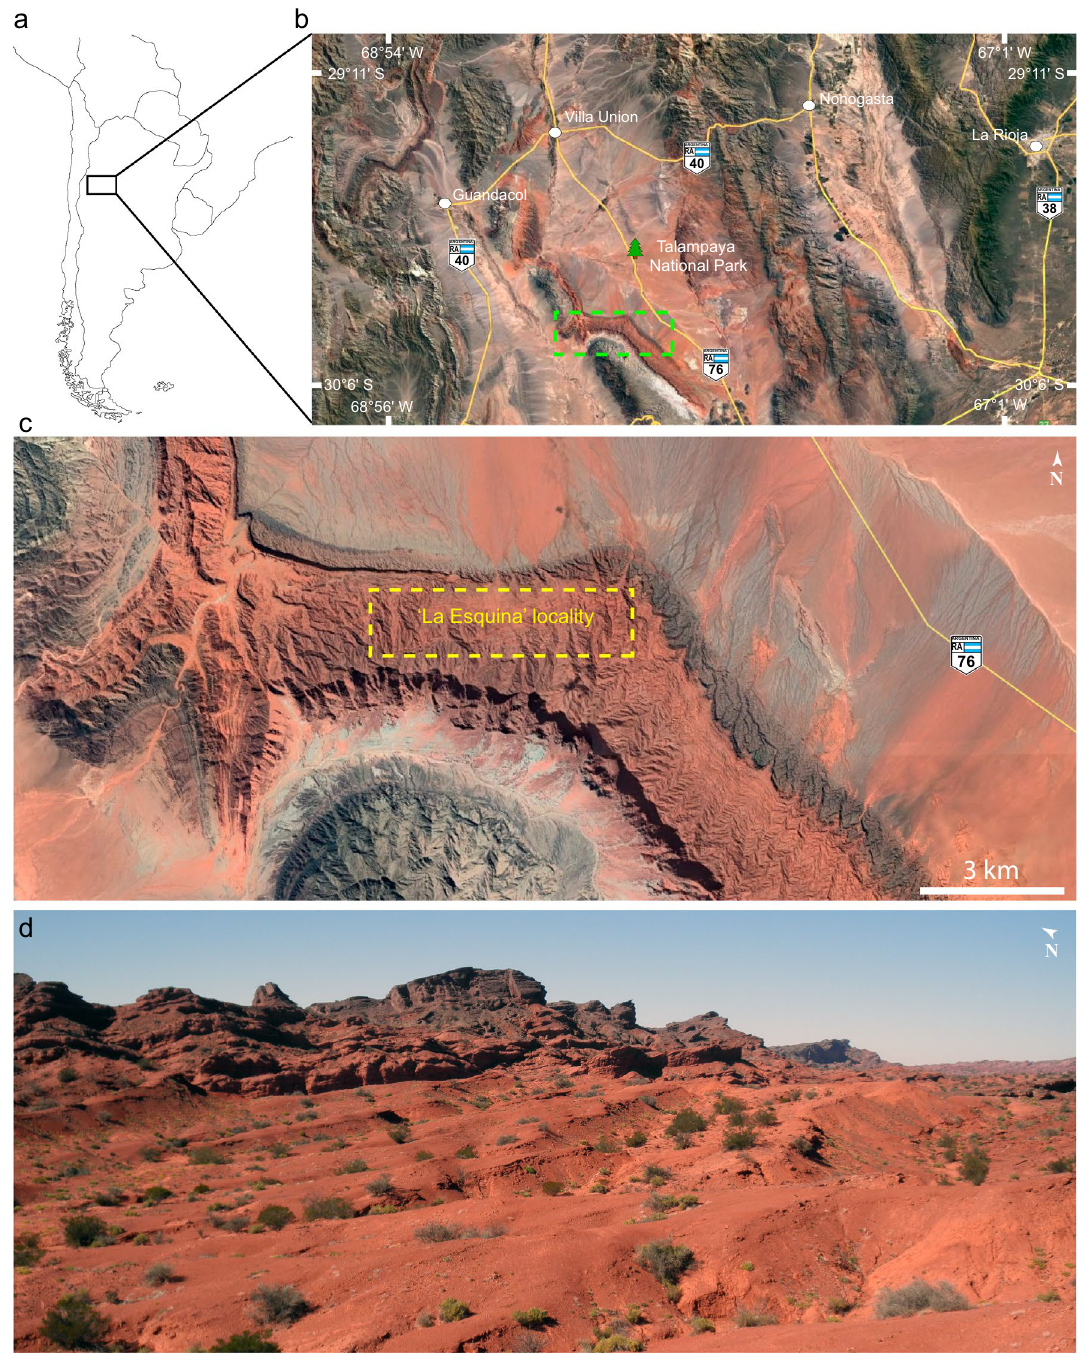
Figure 1. Geographic location of the ‘La Esquina’ locality where Tessellatia bonapartei holotype (PULR-V121) was found. ( a ) Southern South America; ( b ) satellite image of north-western Argentina depicting the study area (green, dotted-line rectangle) within the Talampaya National Park, La Rioja Province; ( c ) satellite image showing the main outcrops of the Los Colorados Formation where the rich faunal assemblage of the ‘La Esquina’ locality was found (yellow, dotted-line rectangle); ( d ) photograph of the outcrops at the ‘La Esquina’ locality portraying the levels from where Tessellatia bonapartei holotype (PULR-V121) was recovered. Map drawn with Adobe Illustrator CC 18 (https:// www. adobe. com/ produ cts/ illus trator. html). Satellite images from Google Earth, accessed December